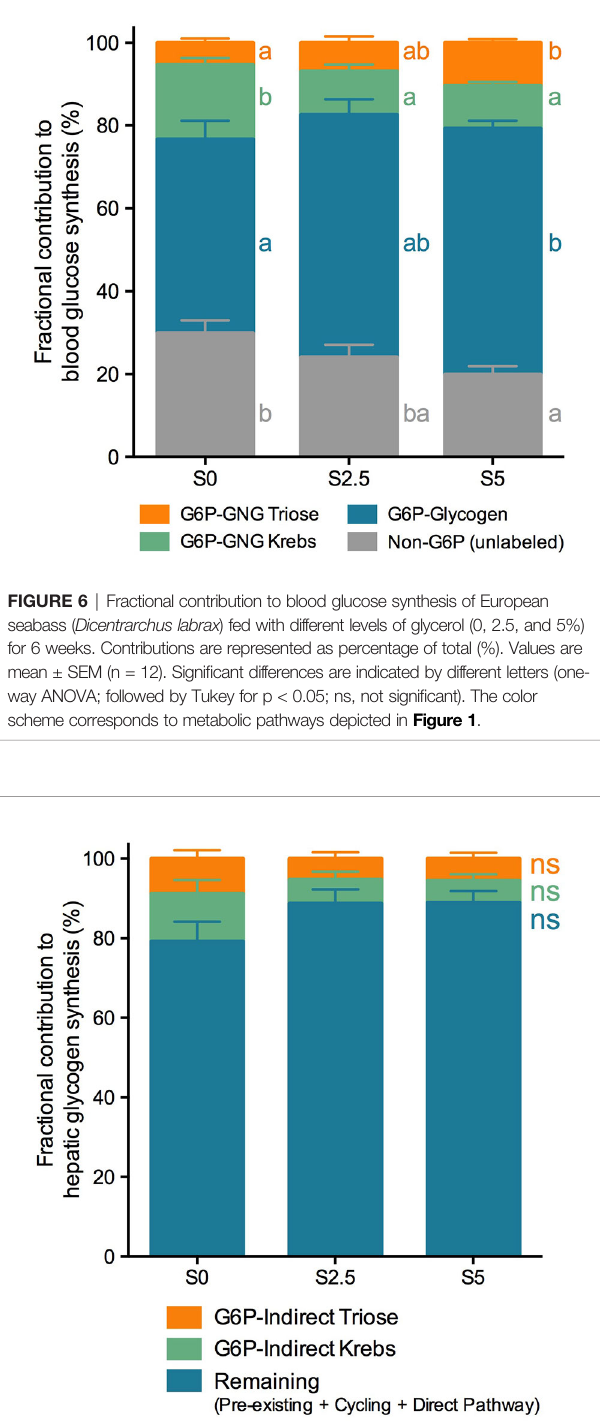
FIGURE 7 | Fractional contribution to hepatic glycogen synthesis of European seabass ( Dicentrarchus labrax ) fed with different levels of glycerol (0, 2.5, and 5%) for 6 weeks. Contributions are represented as percentage of total (%). Values are mean ± SEM (n = 12; one-way ANOVA; followed by Tukey for p < 0.05; ns, not signi fi cant). The color scheme corresponds to metabolic pathways depicted in Figure 1